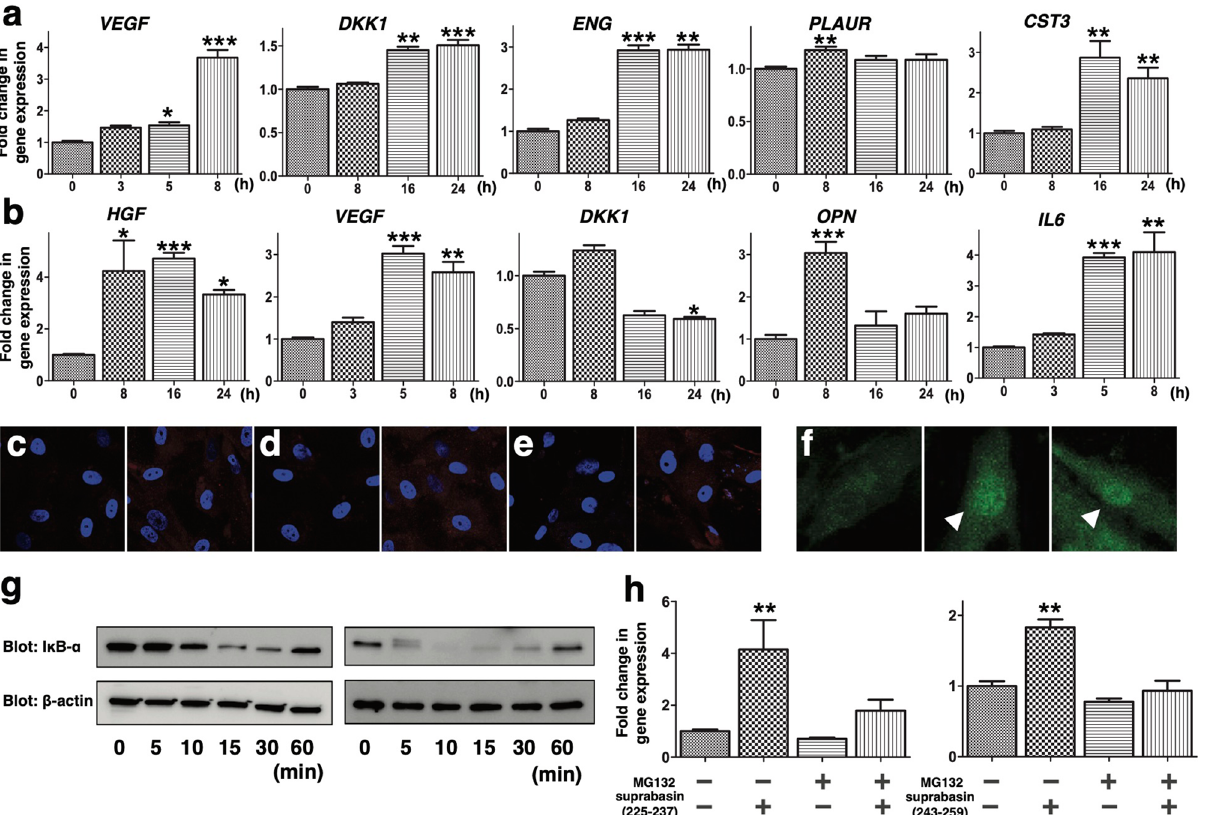
Figure 6. Induction of cytokine expression and activation of NF-κB by SBSN_HUMAN[225–237] and SBSN_HUMAN[243–259]. ( a , b ) Growing HAoSMCs were deprived of serum for 16 h and then replaced with serum-free medium containing 10 –7 M SBSN_HUMAN[225–237] ( a ) or 10 –7 M SBSN_HUMAN[243–259] ( b ) for the indicated times. VEGF , DKK1 , ENG , PLAUR , CST3 , HGF , OPN and IL6 mRNA levels were quantified using real-time RT-PCR. The relative mRNA levels are shown as fold changes (mean ± S.E.M) (n = 6). * p < 0.05, ** p < 0.01, *** p < 0.01 compared with 0 h. ( c – e ) HAoSMCs were serum-starved for 16 h and then incubated for 24 h before (left panels) and after (right panels) the addition of 10 –7 M SBSN_HUMAN[225–237] ( c , d ) or 10 –7 M SBSN_HUMAN[243–259] ( e ) and immunofluorescence staining was performed using antibodies against VEGF ( c ), HGF ( d ) and IL6 ( e ). The red signals correspond to cytokine expression. The nuclei were counterstained with DAPI (blue). ( f ) HAoSMCs were incubated without (left panel), with 10 –7 M SBSN_HUMAN[225–237] (middle panel), or with 10 –7 M SBSN_HUMAN[243–259] (right panel) for 2 h, and immunofluorescence staining was performed using an NF-κB p65 subunit antibody to detect its nuclear translocation (indicated with white arrowheads). ( g ) HAoSMCs were stimulated with either 10 –7 M SBSN_ HUMAN[225–237] (left panel) or 10 –7 M SBSN_HUMAN[243–259] (right panel) for the indicated times, and subjected to western blot analysis using anti-IκB-α and anti-β-actin antibodies to assess the time-course of IκB-α degradation. The panels show the cropped blots and the full-length blots are presented in Supplementary Information. ( h ) HAoSMCs pretreated with or without MG132 (100 nM) for 30 min were incubated with SBSN_HUMAN[225–237] and SBSN_HUMAN[243–259] for 8 h and VEGF mRNA levels were quantified. ** p < 0.01 compared with vehicle. The relative mRNA levels are shown as fold changes (mean ± S.E.M) (n =